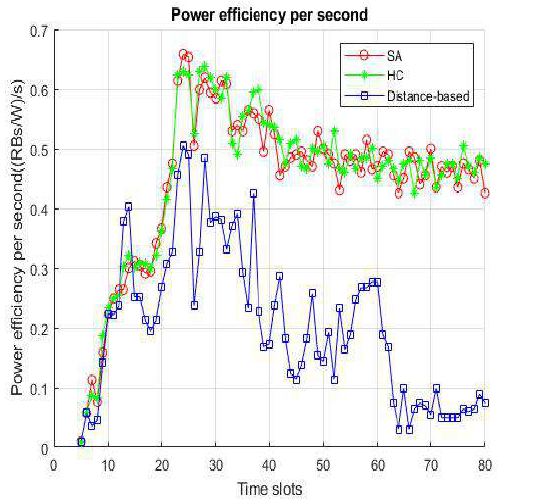
Figure 8. Power efficiency per time slot.